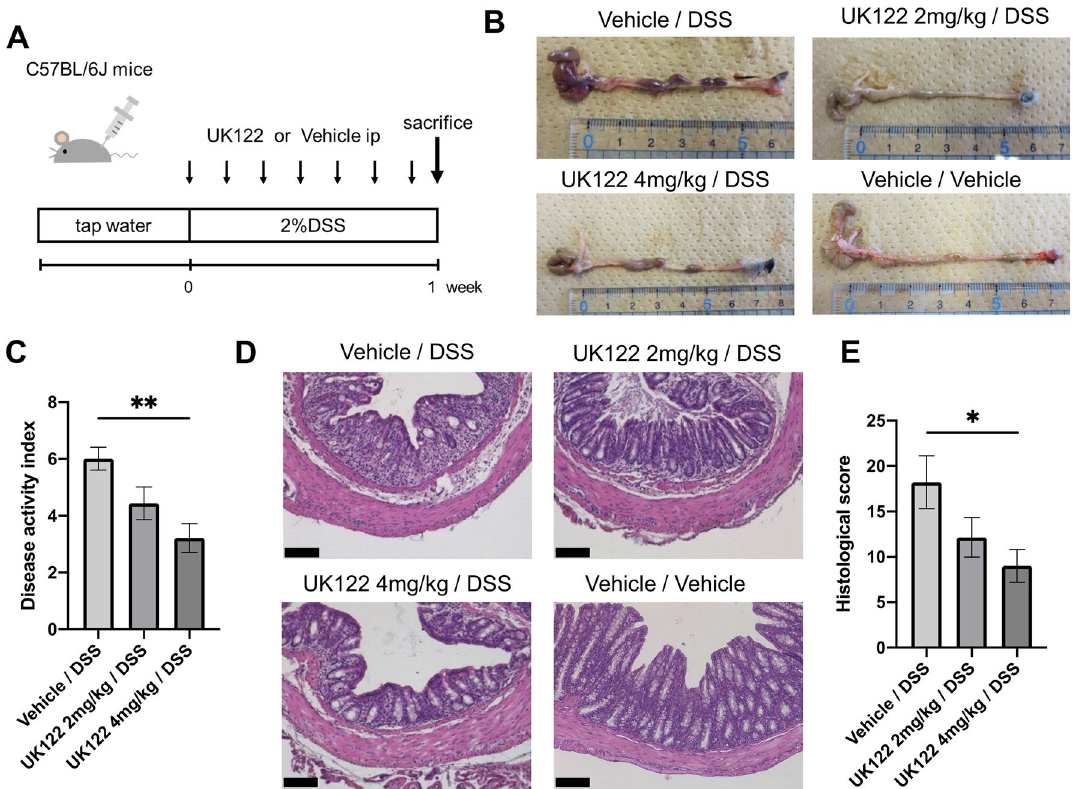
Figure 5. Effect of uPA inhibitor on DSS-induced colitis in C57BL/6 J mice. ( A ) Male mice were administered 2% DSS in their drinking water for 1 week, and intraperitoneally injected with 2 mg/kg or 4 mg/kg UK122 or vehicle from day 1 to day 7 (n = 18 per group). They were sacrificed at day 8. ( B ) Representative macroscopic images of the colon in each group. The lower right panel represents a colorectum of mice that did not receive DSS. ( C ) DAI was evaluated at day 8 by the scoring method of Cooper et al. 10 ( D ) Representative H&E staining images of colon sections in each group. The lower right panel represents a colorectum of mice that did not receive DSS. Scale bar, 100 μm. ( E ) Histologic score of H&E staining image was evaluated by the scoring method of Williams et al. 11 Data represent mean ± SEM. * p < 0.05, ** p < 0.01 by Dunnett’s multiple comparison